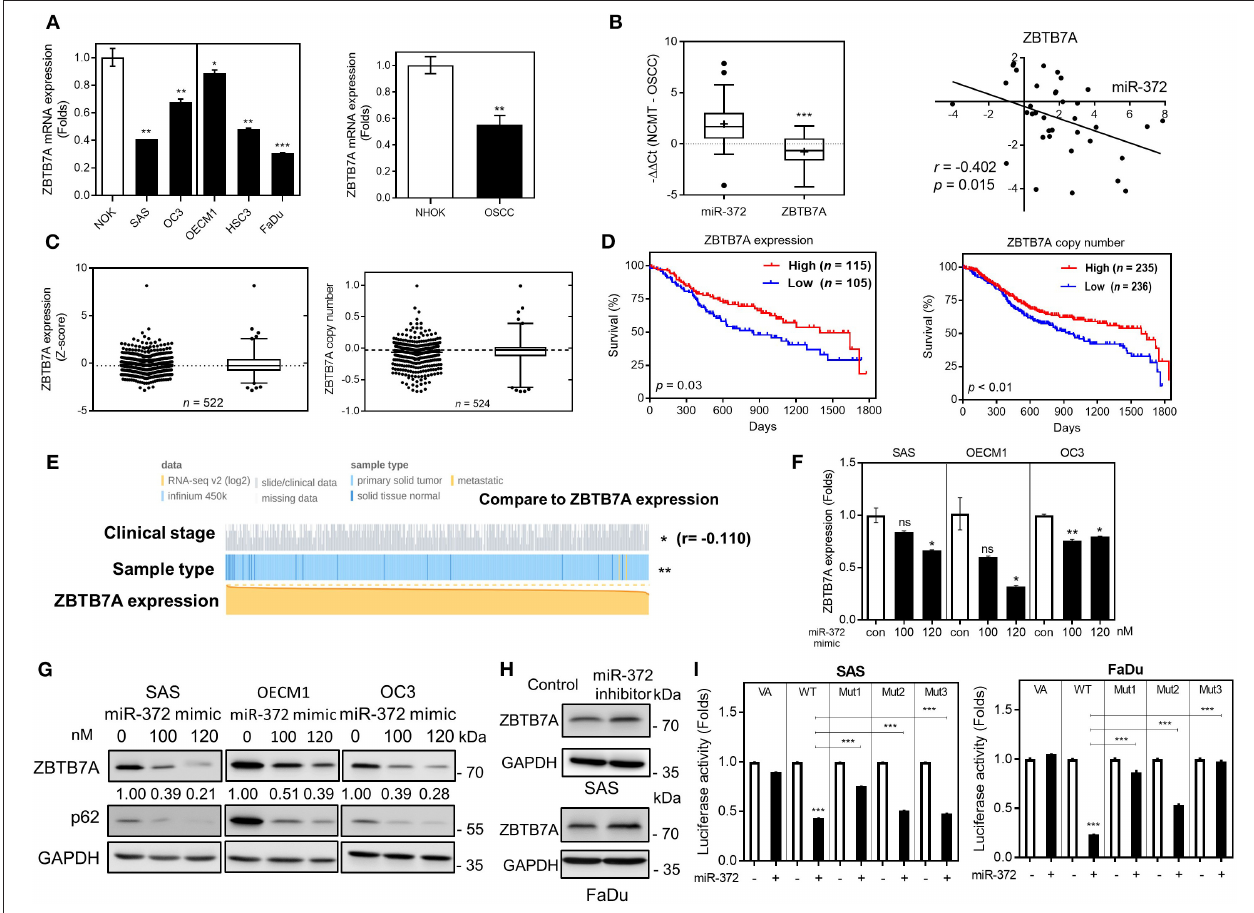
FIGURE 1 | ZBTB7A downregulation in OSCC is due to miR-372 targeting. (A) ZBTB7A mRNA expression in OSCC cell lines and normal oral keratinocytes (NOK). Lt panel, individual comparison. Vertical line separates cells having wild-type p53 (Lt) and mutant p53 (Rt). Rt panel, overall comparison. (B) qRT-PCR analysis of OSCC tissue pairs. Lt, upregulation of miR-372 expression and downregulation of ZBTB7A mRNA expression in OSCC tumors. Rt, correlation analysis showing a reverse correlation between miR-372 expression (X-axis) and the ZBTB7A mRNA expression (Y-axis) in tumors. (C–E) Analysis of the TCGA HNSCC database. (C) Lt, ZBTB7A expression. Rt, ZBTB7A copy number. In each figure panel, both dot plot (Lt) and Box-and-Whiskers plot (Rt) are shown. Median values marked by dot-lines and are used as cut-offs in order to define high vs. low. (D) Kaplan-Meier analysis of patient overall survival according to ZBTB7A expression (Lt) and ZBTB7A copy number (Rt). (E) Association between ZBTB7A expression and clinicopathological parameters. ZBTB7A expression is significantly associated with sample origin (normal tissue vs. tumor tissue) and stages. r in (B,E) , correlation coefficient. (F,G) miR-372 expression downregulates ZBTB7A mRNA expression (in F ) and protein expression (in G ) in a dose-dependent manner. (H) miR-372 inhibition slightly upregulates ZBTB7A expression in SAS (Upper) and FaDu (Lower) cells. (I) Luciferase reporter assay showing the direct targeting of miR-372 onto the 3’UTR of ZBTB7A (VA, vector alone; WT, wild-type reporter; Mut1–Mut3, mutant reporters). The potential target sequences within the wild-type reporter are replaced by restriction enzyme sites in the three mutant reporters. ns , not significant, * p < 0.05; ** p < 0.01; *** p < 0.001.